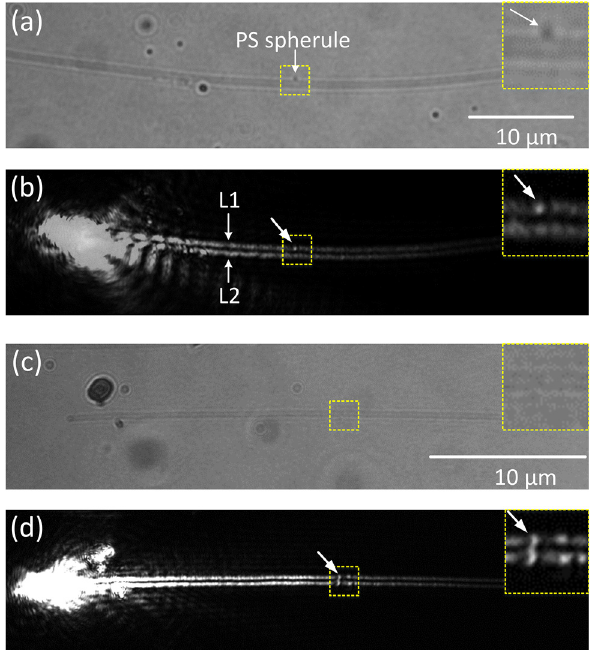
Figure 5: Sensing of the propagating SPs to environmental changes. (a, c) The bright-field images of the Ag NW. (b, d) The corresponding images of SPs propagating along the Ag NW for (a, c). On (a, b), the environmental change is induced by a PS nanoparticle attached on the top side-wall of the Ag NW. On (c, d), there is something on this Ag NW, which cannot be observed on the bright- fi eld image (c), but can be observed on the plasmonic image (d), as shown in the area marked with dashed line box. The enlarged images of the perturbed areas are included as the inset graphs (top right corner on (a – d)). The scale bar in (a) is applicable for (b) and in (c) is applicable for